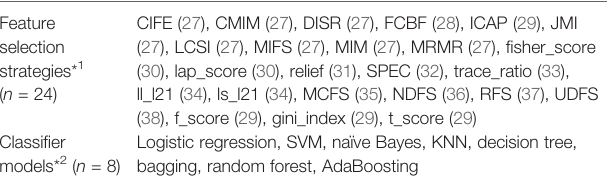
TABLE 2 | Feature selection strategies and classi fi ers for discrimination modeling. Feature selection strategies* 1